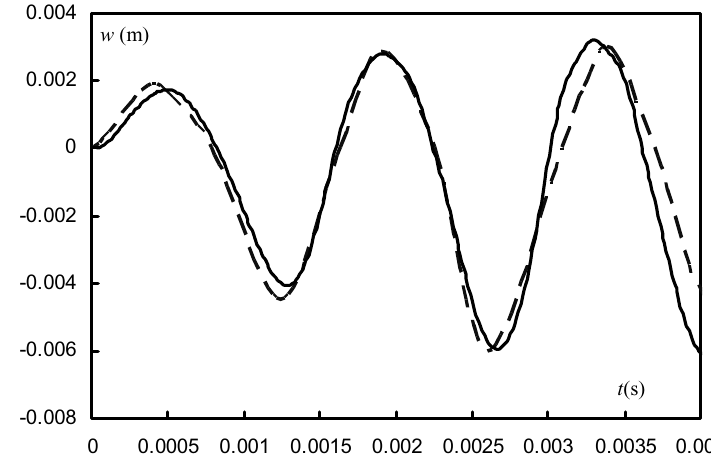
Fig. 5. Displacements of point 2 in the z direction computed with the p -version model ( — ) and with Abaqus (-